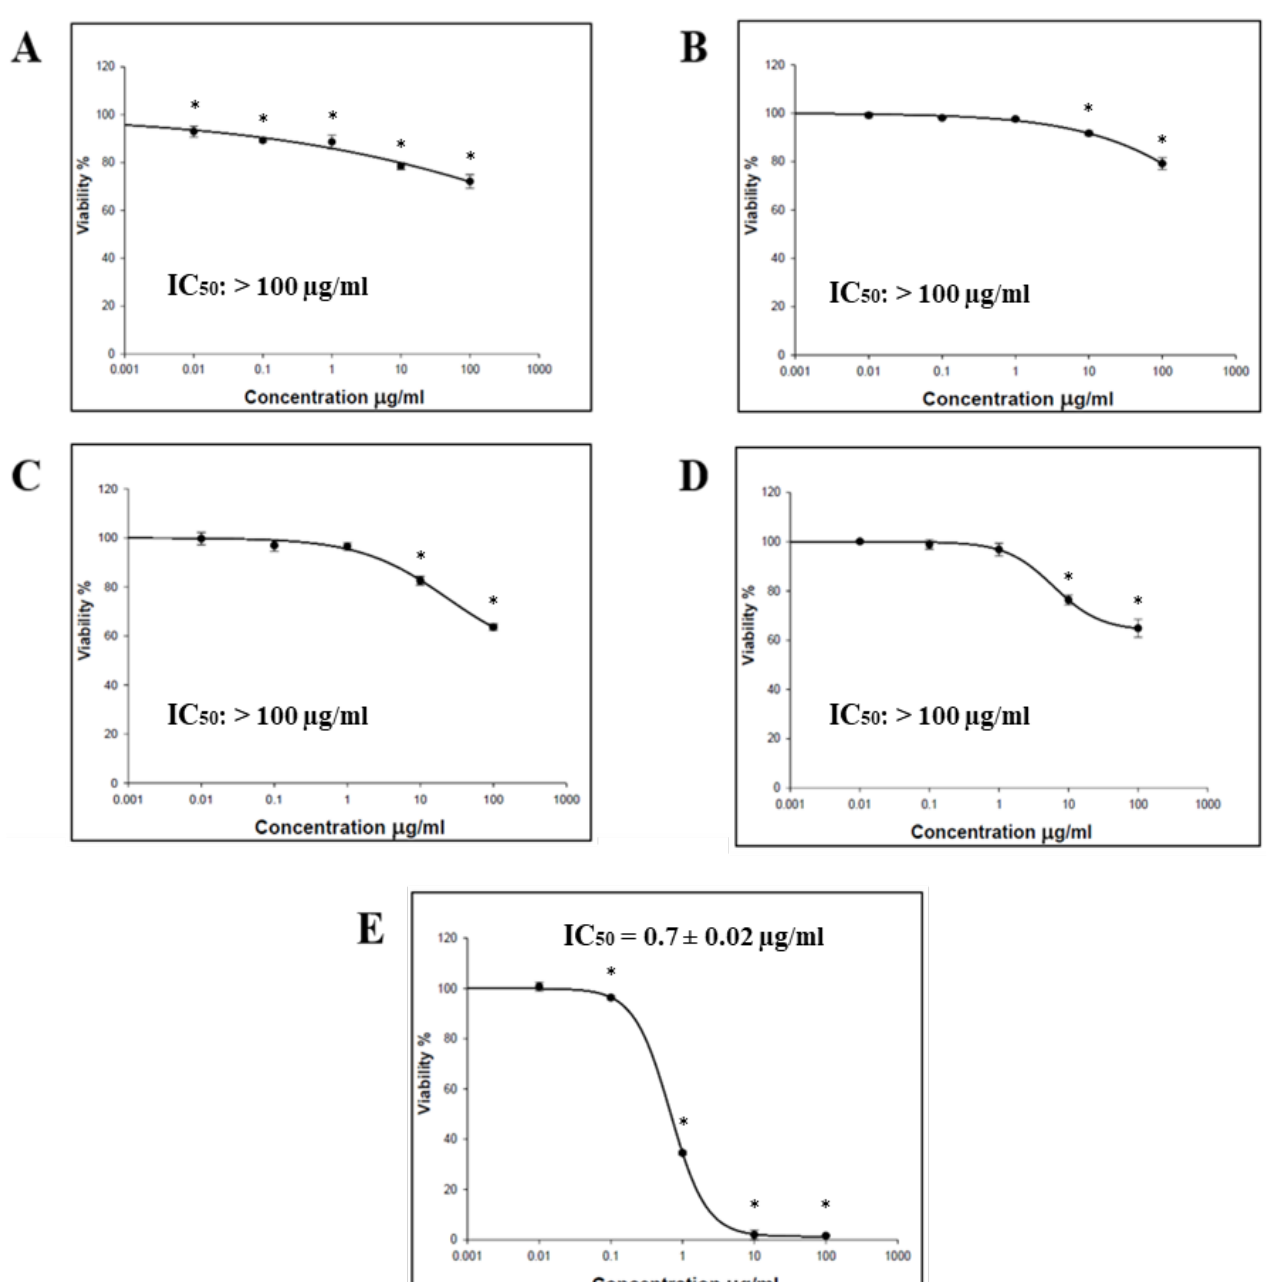
Figure 2 . Representative dose–response plots demonstrating the effect of different O. baccatus methanolic extracts on HepG2 cancer cell growth: ( A ) whole plant’s extract; ( B ) flowers’ extract; ( C ) branches’ extract; ( D ) roots’ extract; and (E ) doxorubicin. The experiment was repeated three times. Dots and error bars represent mean ± S.D. * p < 0.05 vs. control .